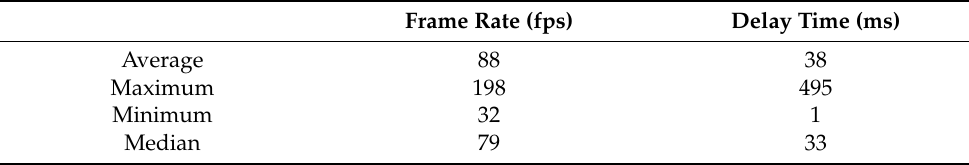
Table 2. Performance